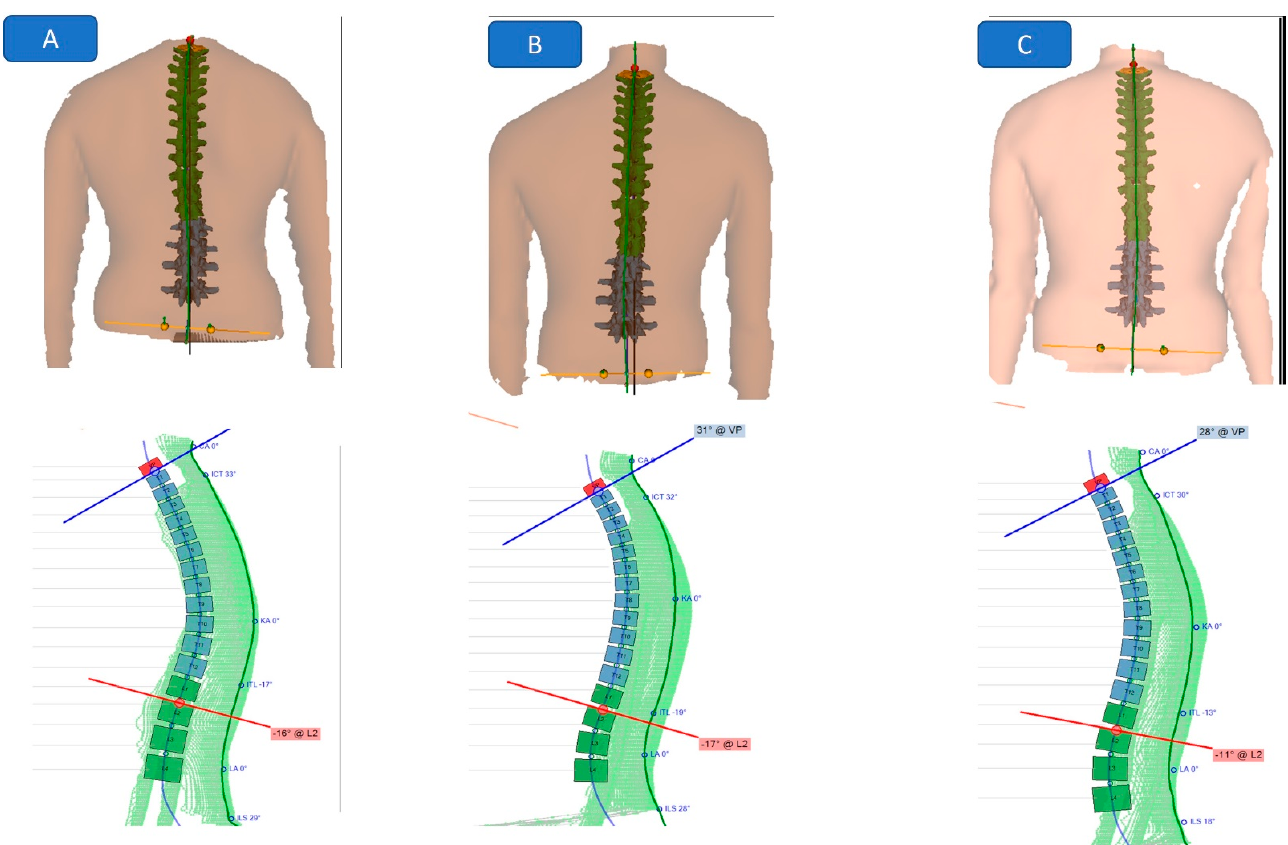
Figure 4. Formetric findings at the three intervals of measurement for a representative patient in the study group: In the left ‐ hand column is the sagittal plane surface profile of the thoracic and lumbar spines while the right ‐ hand column is the posterior view of the coronal and transverse aspects of posture deformity for the thoracic, lumbar, and top of the pelvic regions. ( A ) pre ‐ treatment; ( B ) 10 ‐ weeks post ‐ treatment; and ( C ) is the 6 ‐ month follow